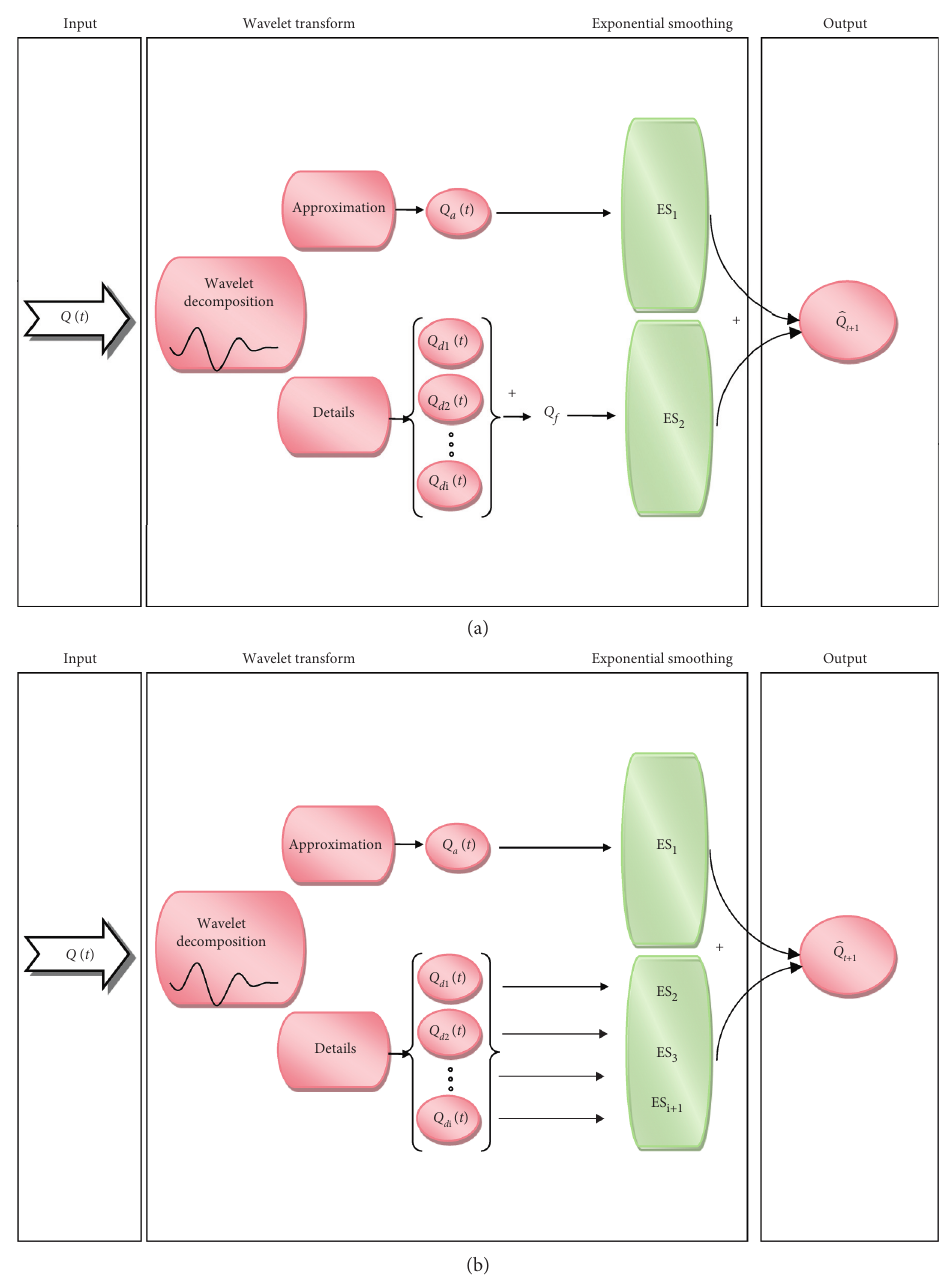
Figure 3: Structure of the proposed methods. (a) WES